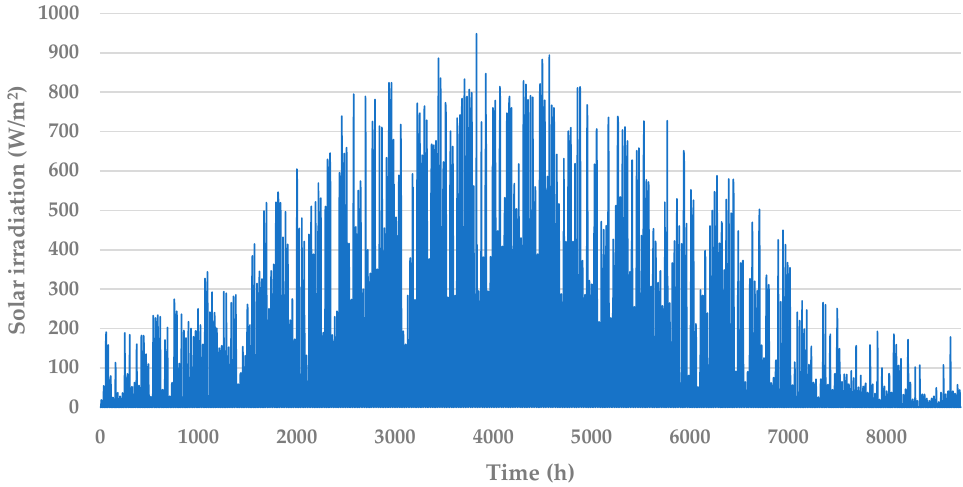
Figure 5. Hourly solar radiation at the analyzed site.